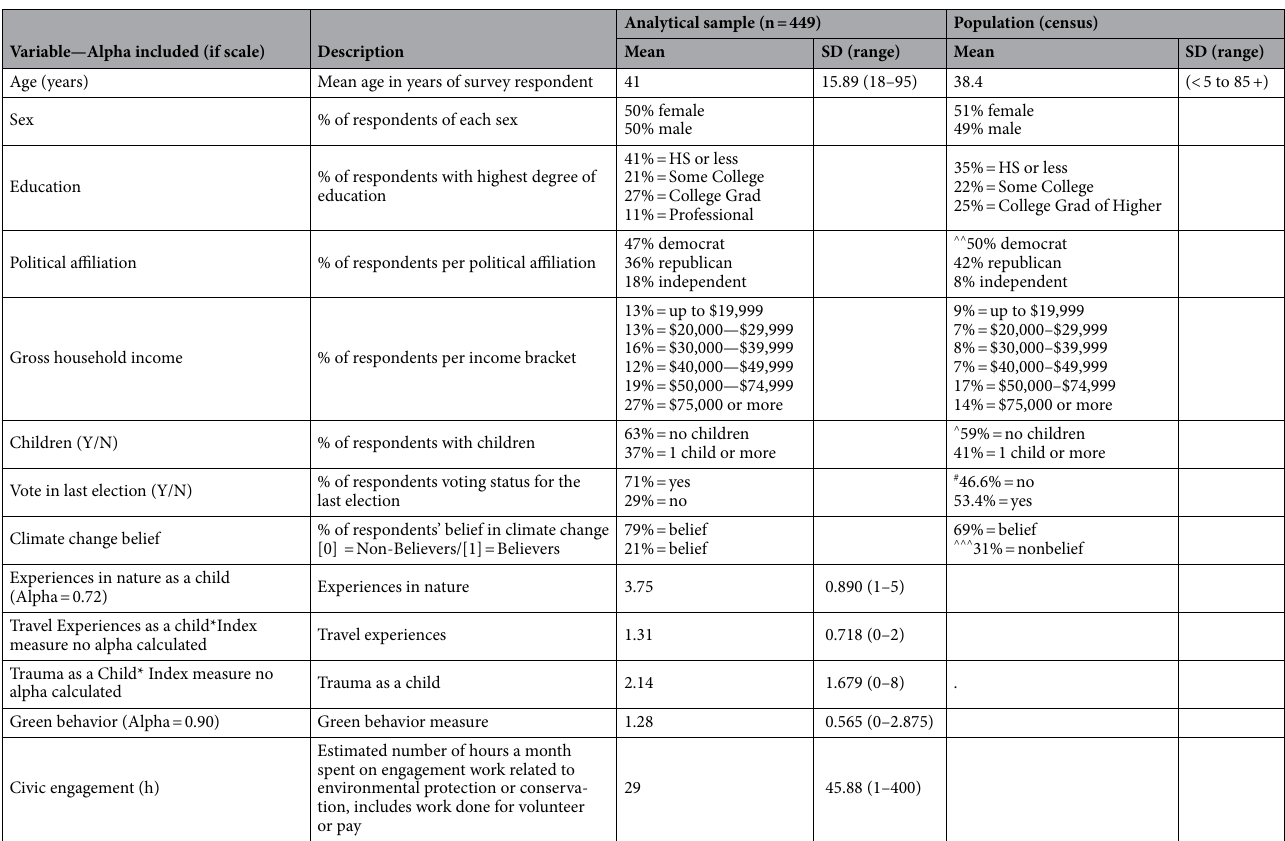
Table 1. Description of key study variables and descriptive statistics. *Mean is reported unless another statistic is indicated in the description. ^ Statista.com. # 2018 Voter Turnout: U.S Census Bureau: Current Population Survey Voting and Registration Supplements: 2014–2018. ^^ Based on Pew Research Estimates of Registered Voters % that lean Democrat and Republican Per Estimated 2017 Voter Turnout Estimates: Report: Trends in Party Affiliation Among Demographic Groups. ^^^ Based on an NBC National Poll Climate Change in the American Mind conducted in March 2018. 1 Census Data was obtained from the 2018 American Community Survey Estimates Tables. 2 Descriptives include